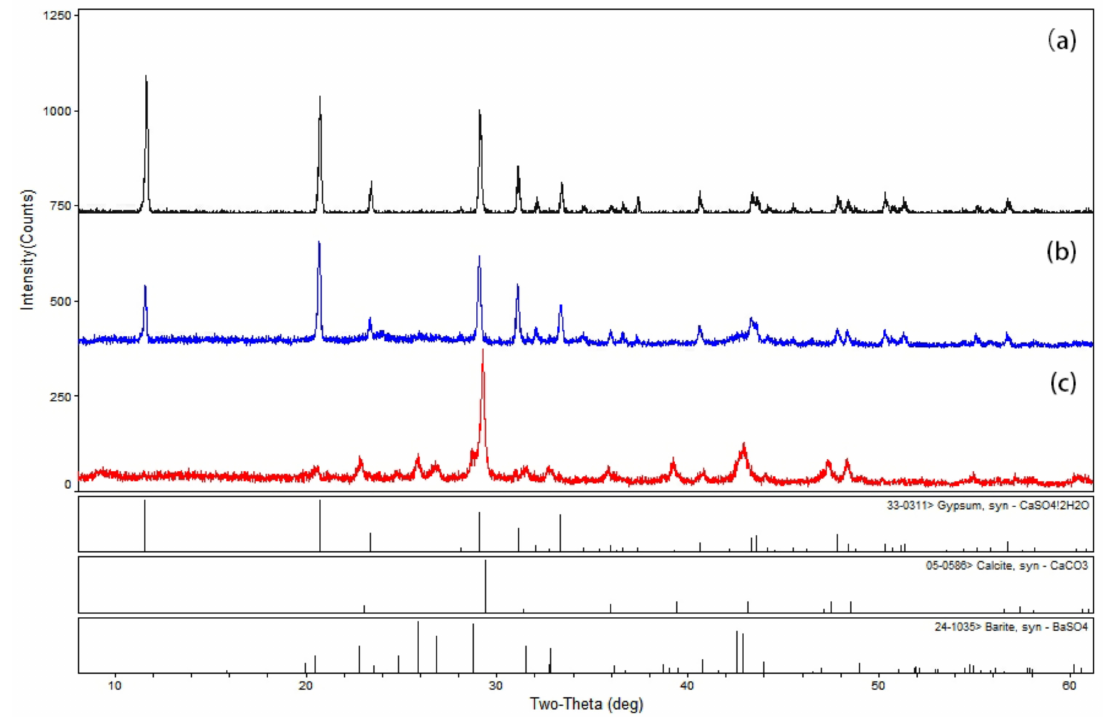
Figure 3. XRD results of the specimens: ( a ) blank specimen, ( b ) treated specimen before water supply, ( c ) treated specimen after water